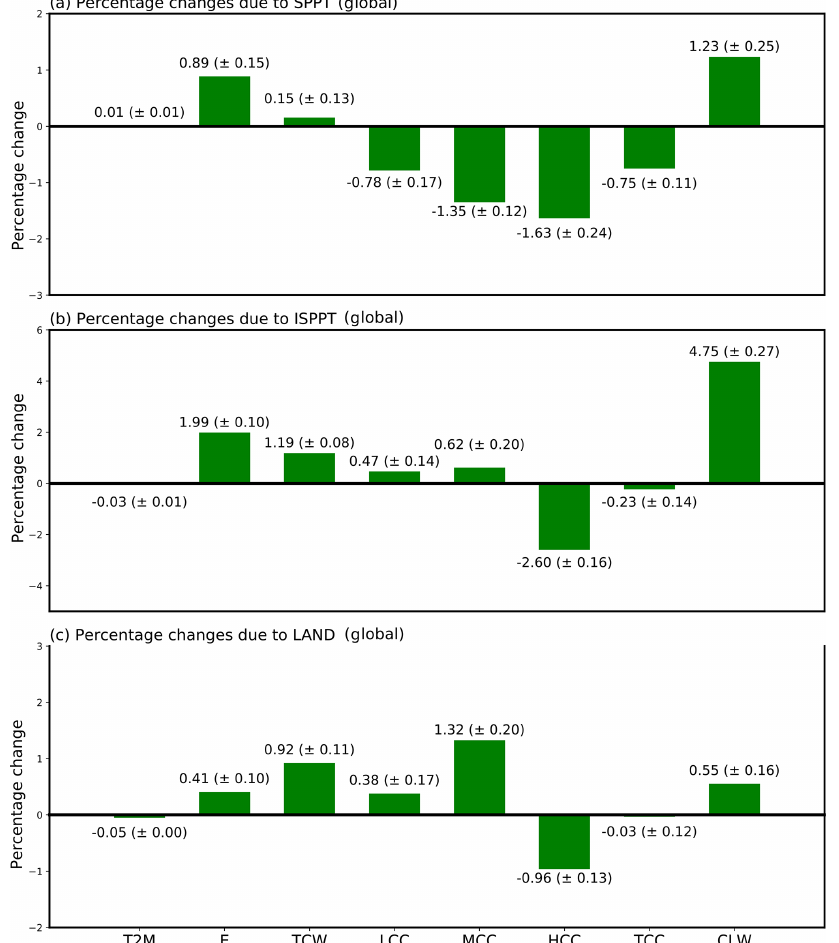
Figure 1. Average percentage change, relative to the CTRL, in the global mean of (a) SPPT, (b) ISPPT, and (c) LAND simulations. Variables shown (see the x axis of (c) ) are as follows: 2m temperature (T2M), evaporation ( E ), total column water (TCW), low cloud cover (LCC), mid-level cloud cover (MCC), high-level cloud cover (HCC), total cloud cover (TCC), and cloud liquid water (CLW). Uncertainty estimates are twice the standard deviation of the five individual differences. Note that, due to conservation of water, the change in precipitation (not shown) is almost exactly equal to the change in